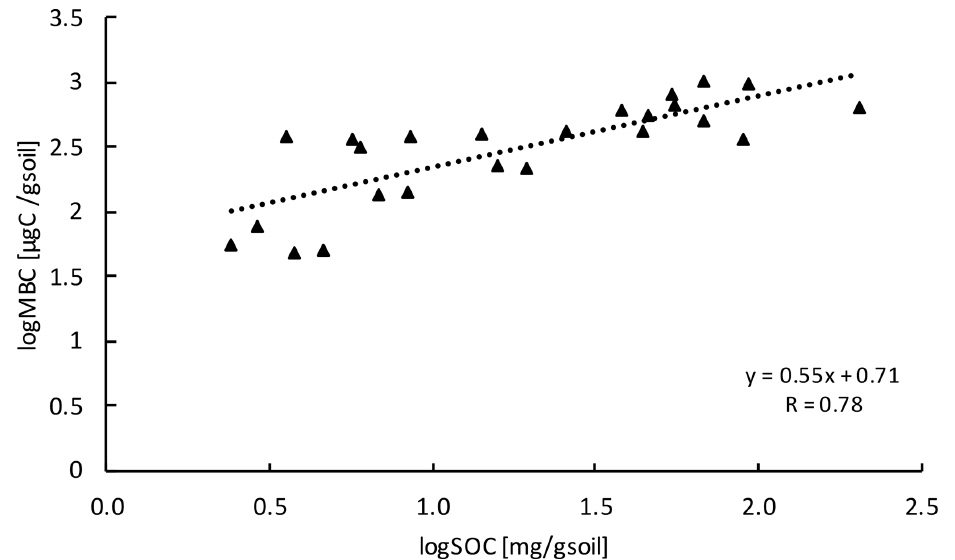
Figure A2. Relationship between MBC and SOC at all depth increments ( n = 24). Values were log transformed to meet normality.